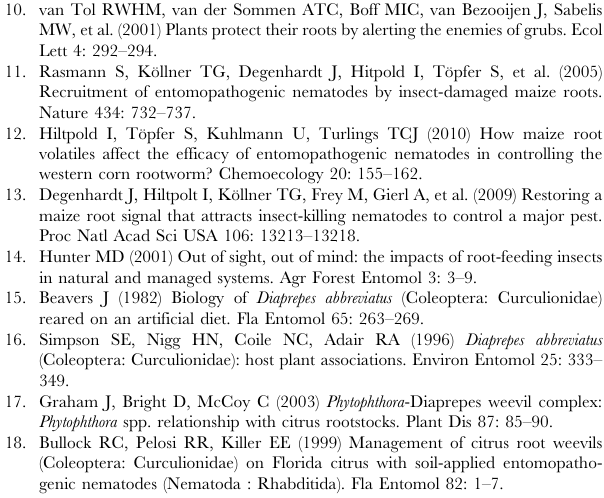
Figure S5 Schematic diagram of the deployment and sampling procedure for field experiments in which sentinel traps with root weevils were deployed with or without HIPVs. One treatment replicate is depicted. (TIFF) Table S1 1 H (600 MHz), 13 C (151 MHz), HMBC and NOESY NMR spectroscopic data for pregeijerene in C 6 D 6 . 13 C was also detected directly (126 MHz) using a 5 mm Cryoprobe. Chemical